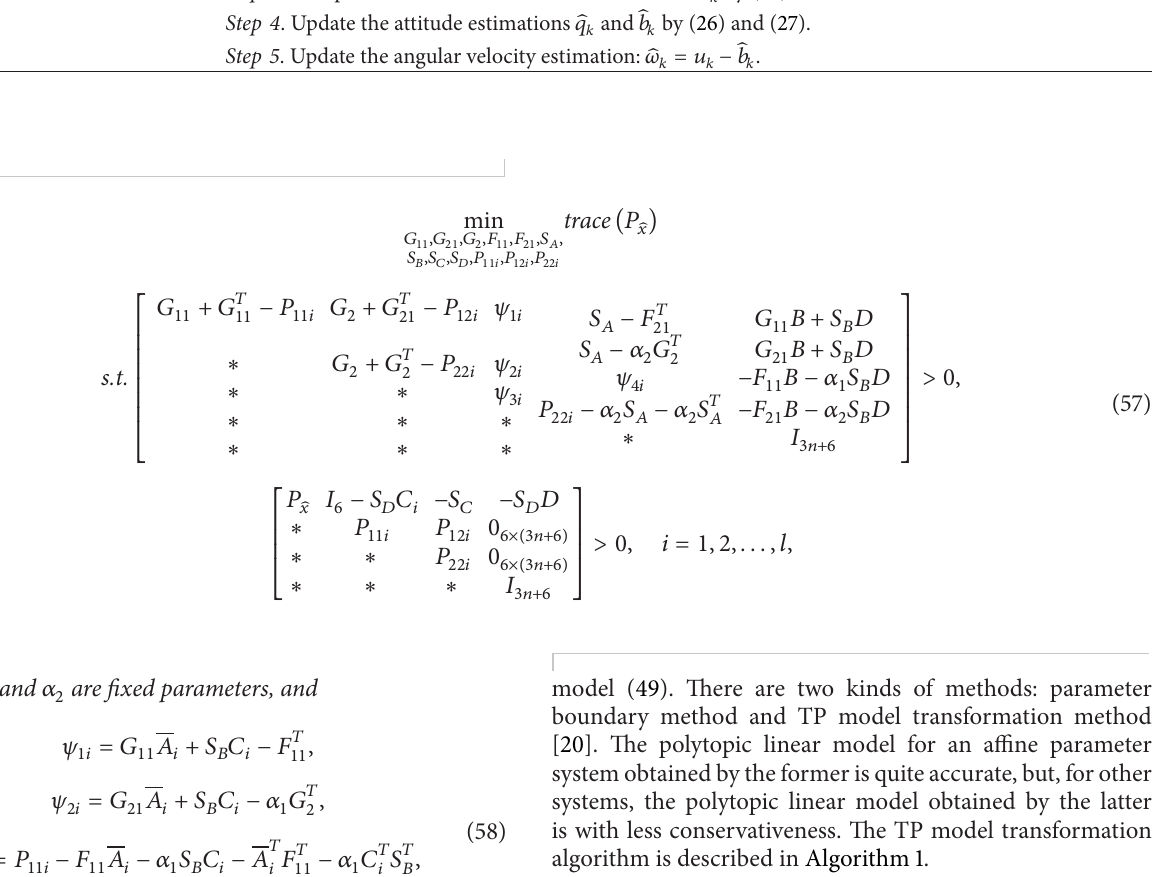
Initialization Estimator (one cycle)